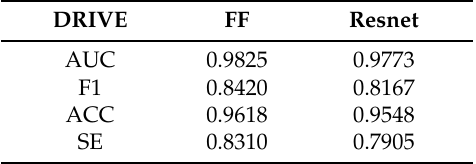
Table 5. Comparative analysis of feature fusion and